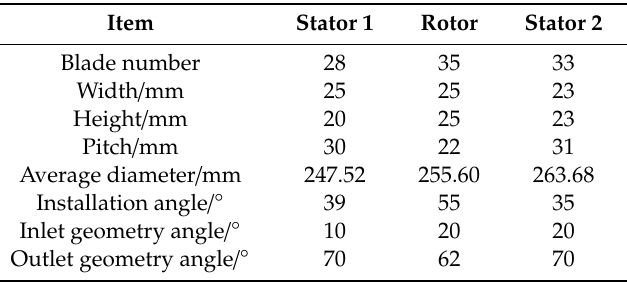
Figure 1. Schematic diagram of the 1.5-stage turbine. Table 1. The geometry parameters of stator and rotor blades.